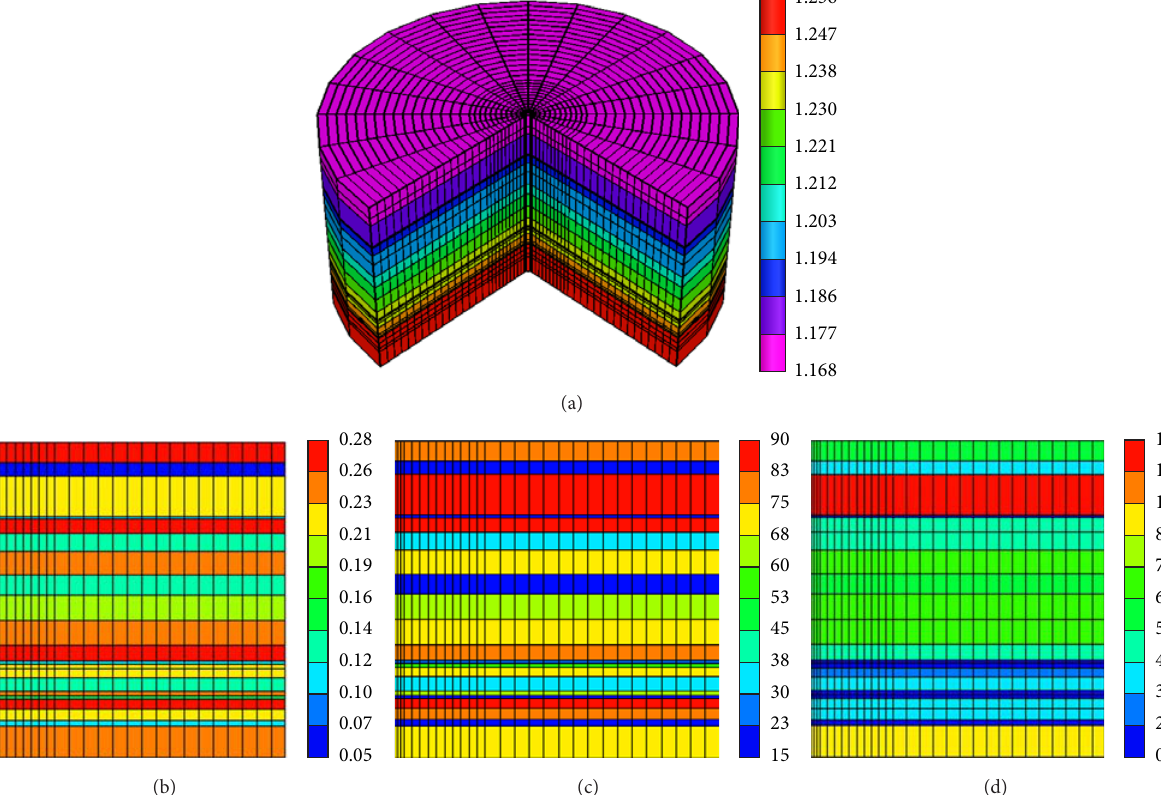
Figure 3: Single-well radial plane model of the southeast oilfield (CMG STARS, Ver. 2012). (a) 3D sectional view of depth, (b) grid porosity, (c) grid permeability (mD), and (d) grid thickness (m).